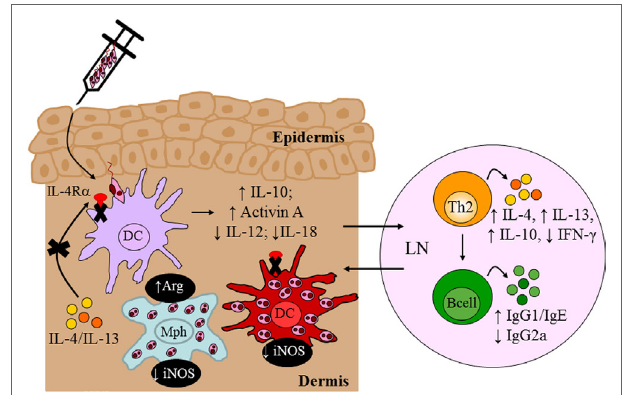
FiGURe 7 | Immune response in BALB/c mice deficient for interleukin-4 receptor alpha (IL-4R α )-responsive DCs. Absence of interleukin-4 (IL-4)/ interleukin-13 (IL-13) signaling on DCs led to hypersusceptibility in BALB/c mice upon Leishmania major LV39 and IL81 infection in the footpad, characterized by a shift to Th2/type II immune responses and alternatively activated macrophages stronger than that usually observed in littermate BALB/c mice. Expression of inducible nitric oxide synthase (iNOS) in DCs was also dramatically reduced with increased arginase (Arg) compared to littermate mice providing a safe haven for L. major growth, survival, and dissemination to peripheral organs. Illustration prepared from Hurdayal et al. (11). DC, dendritic cells; Mph, macrophage; LN, lymph node; Th2, T helper